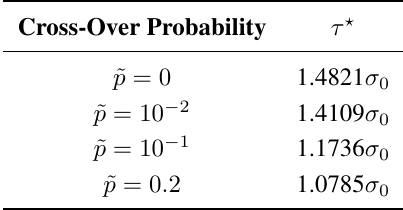
Table 1. Optimum quantization threshold in perfect/BSC